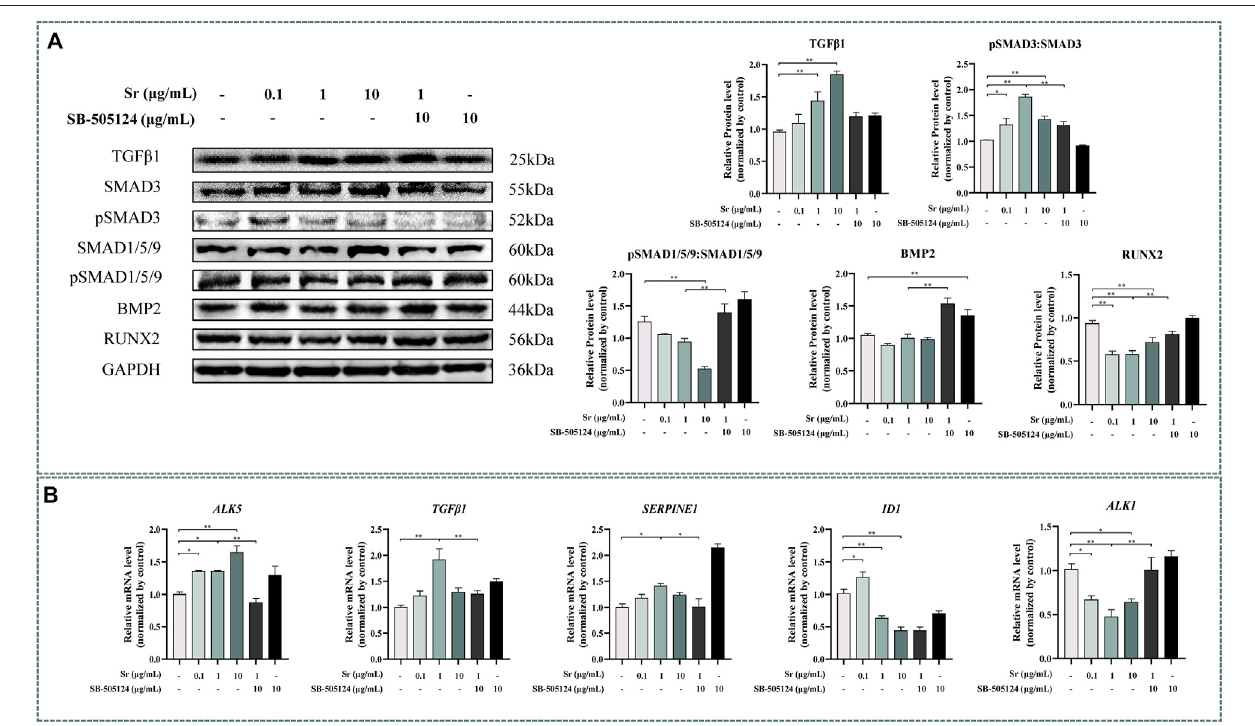
FIGURE 2 | Effects of Sr and SB-505124 on the transforming growth factor β (TGF β )/SMAD family member (SMAD) signaling pathway and downstream gene transcription in bovine chondrocytes. Chondrocytes were treated with different doses of Sr (0, 0.1, 1, 10 μ g/ml) with or without activin receptor-like kinase 5 (ALK5) kinase inhibitor (10 μ M SB-505124). (A) Western blot analysis and relative protein expression levels of SMAD3, pSMAD3, SMAD1/5/9, pSMAD1/5/9, TGF β , bone morphogenetic protein 2 (BMP2), and runt-related transcription factor 2 (RUNX2). (B) mRNA expression levels of TGF β 1, serpin family E member 1 (SERPINE1), ALK5, ALK1, and inhibitor of DNA binding 1 (ID1). All experiments were repeated at least thrice. Data are means ± SEM ( n = 3 in each group) * p < 0.05; ** p <